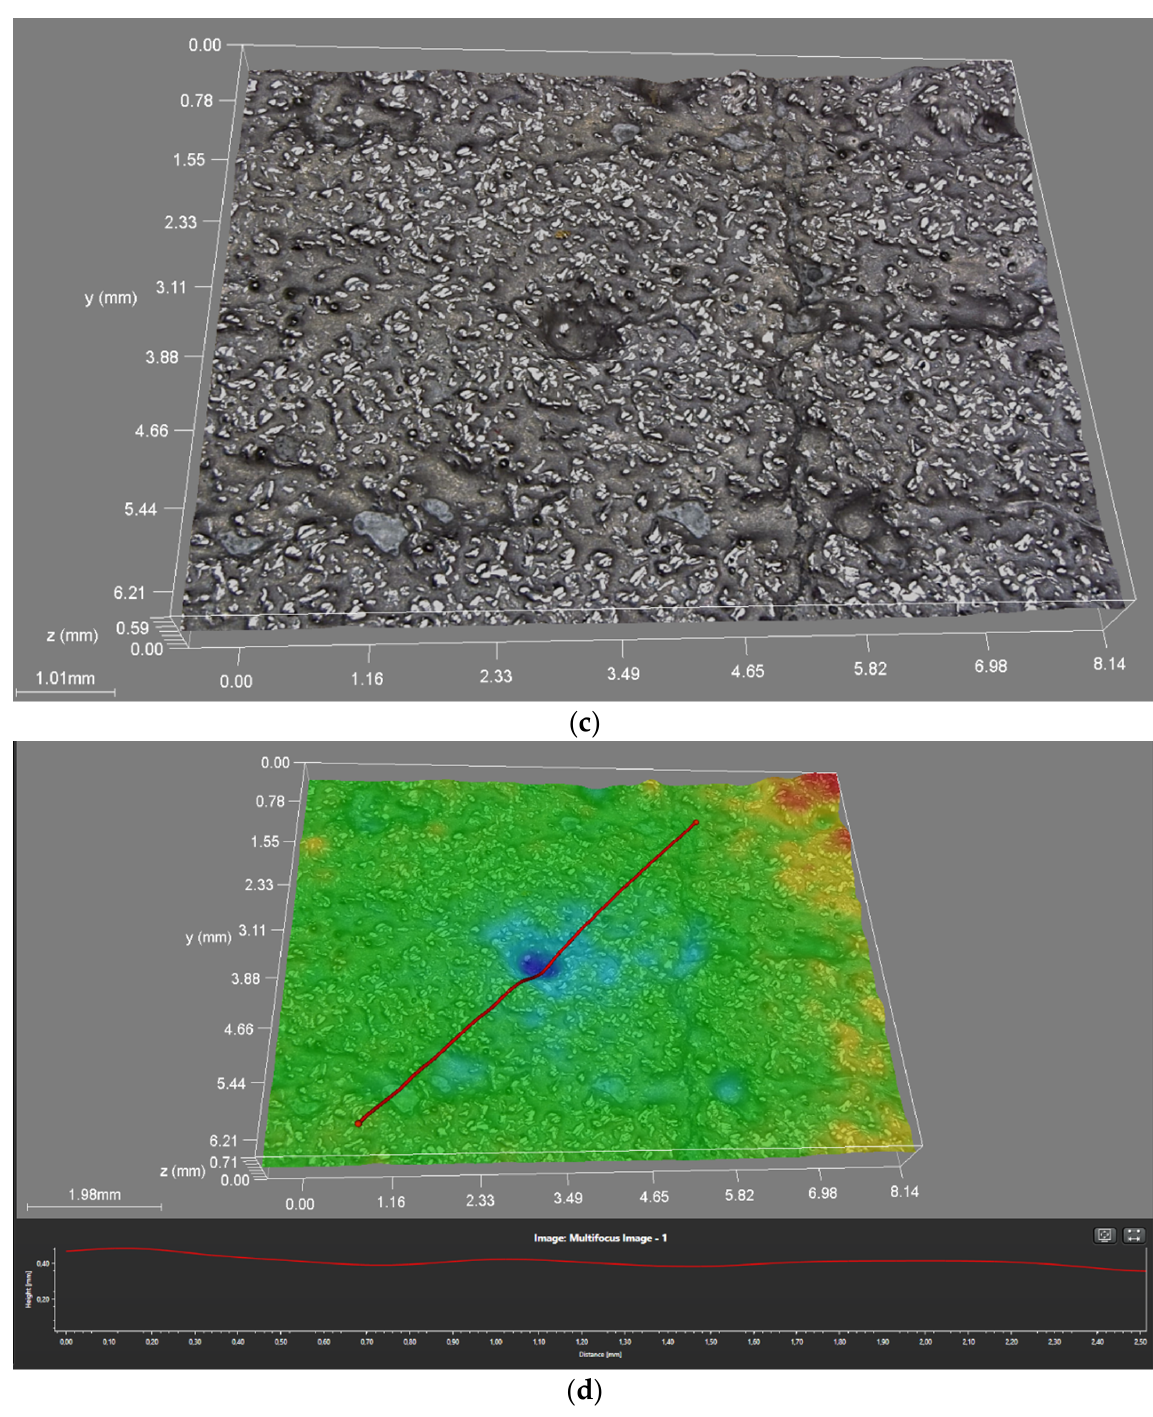
Figure 16. Surface of the composite layer after the metal-mineral abrasive wear resistance test observed using the confocal microscope: ( a , c ) main view of specimen wear, ( b , d ) measurement of defects (single craters).